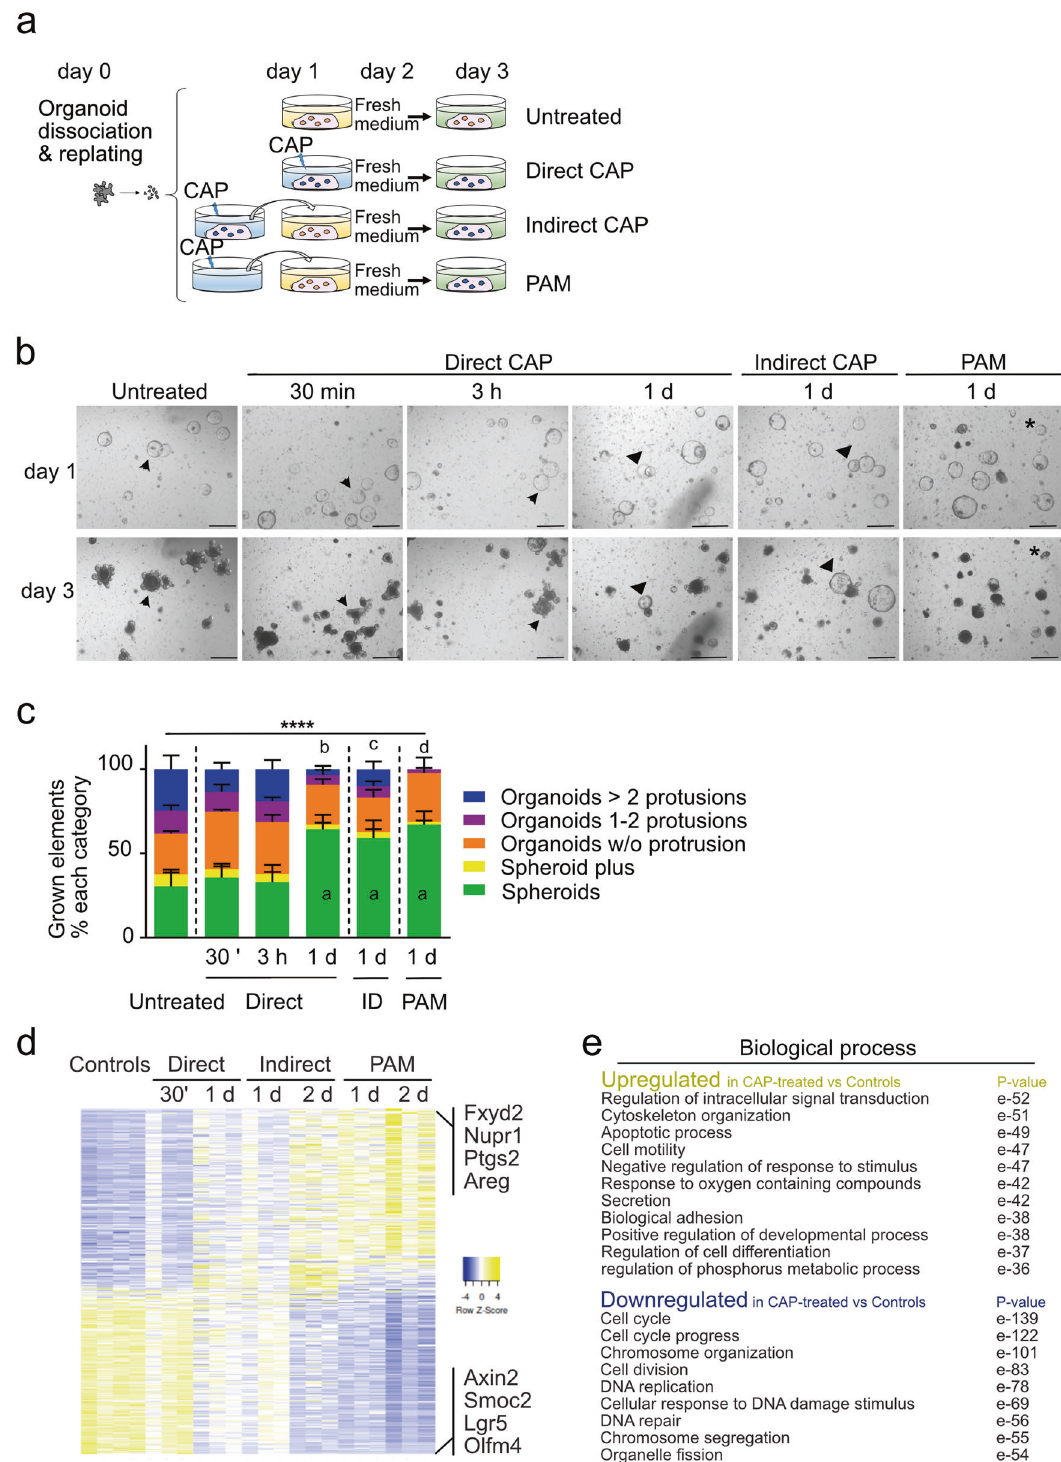
application (Supplementary Fig. 2Sb). Of note, the major cellular enzymatic ROS scavengers (superoxide dismutases, glutathione peroxidases, peroxiredoxins, and catalase) were detected at high levels in control organoids but their expression did not substantially differ upon CAP treatment (Supplementary Table 1). Pparg , a master regulator of lipid metabolism and immune response [20], was also found upregulated in CAP-treated